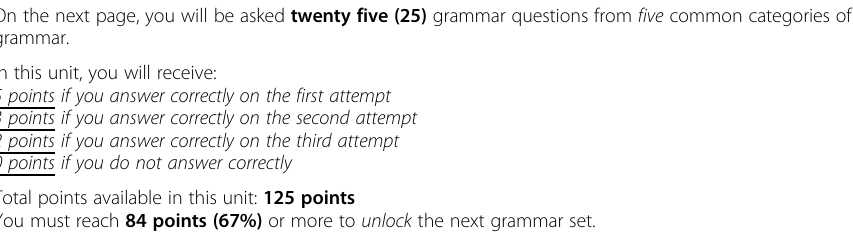
Table 3 Instructions shown before a grammar